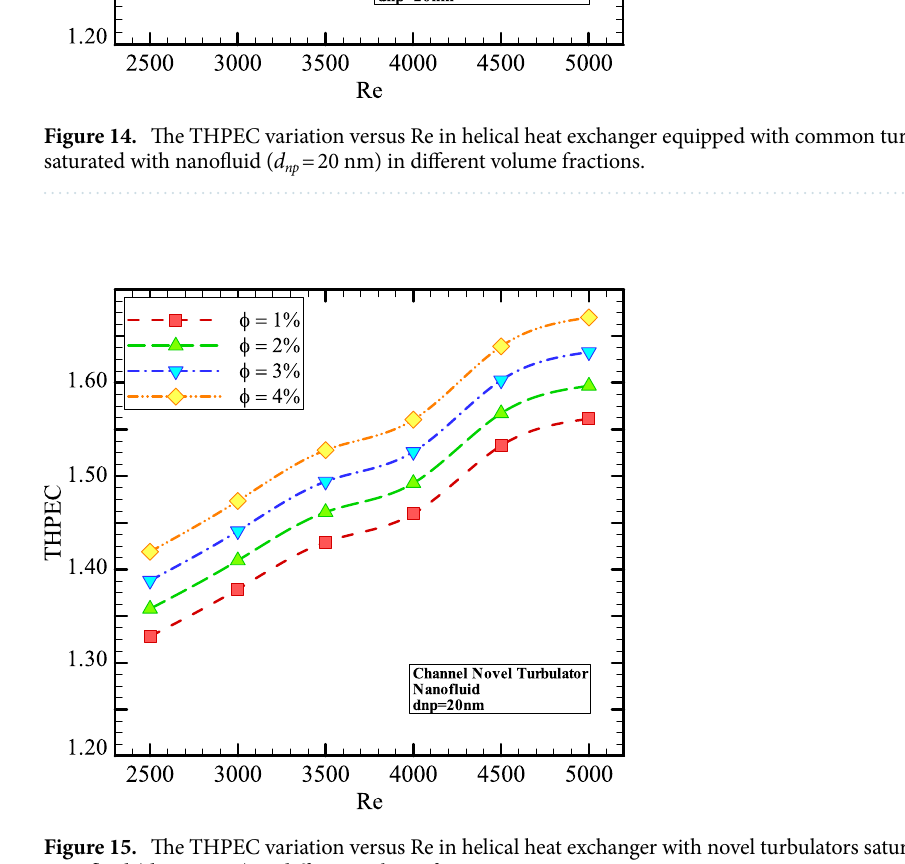
Figure 15. The THPEC variation versus Re in helical heat exchanger with novel turbulators saturated with nanofluid ( d np = 20 nm) in different volume